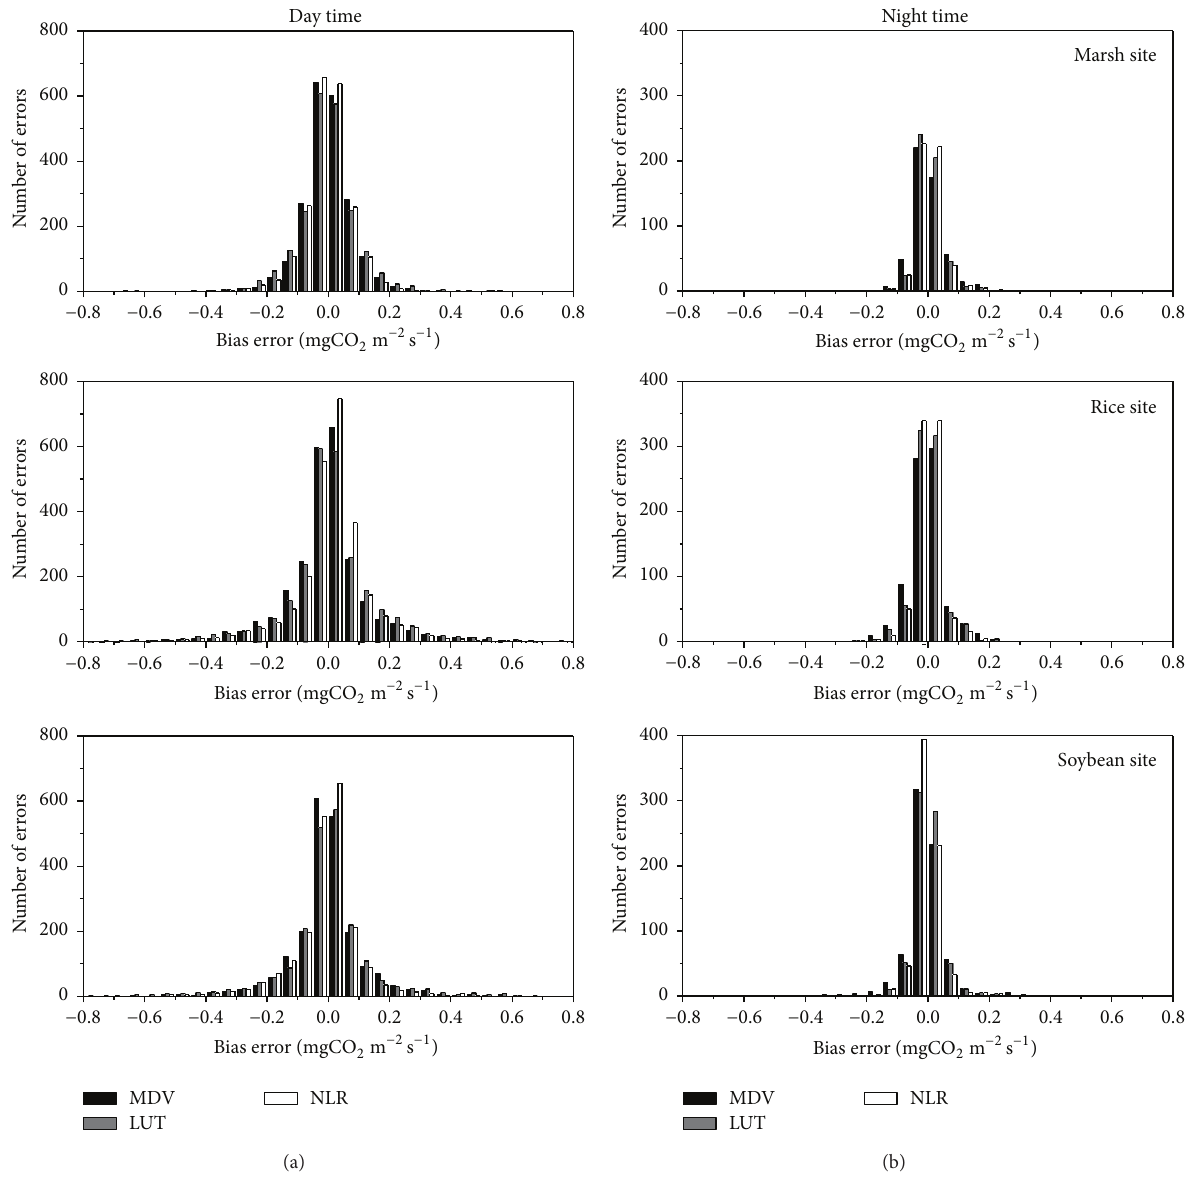
Figure 3: Frequency distribution of bias error with different methods for 65% artificial gaps at three sites, separated into daytime (a) and nighttime (b)